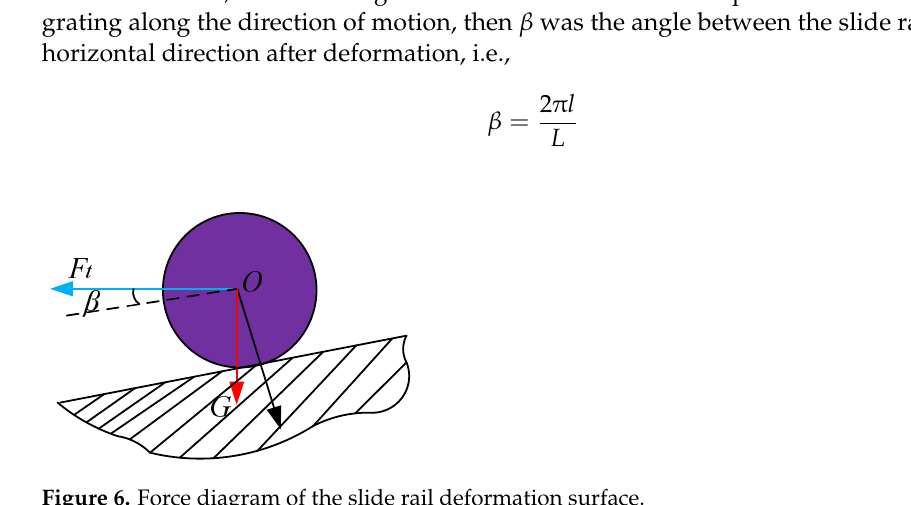
Figure 6. Force diagram of the slide rail deformation surface.